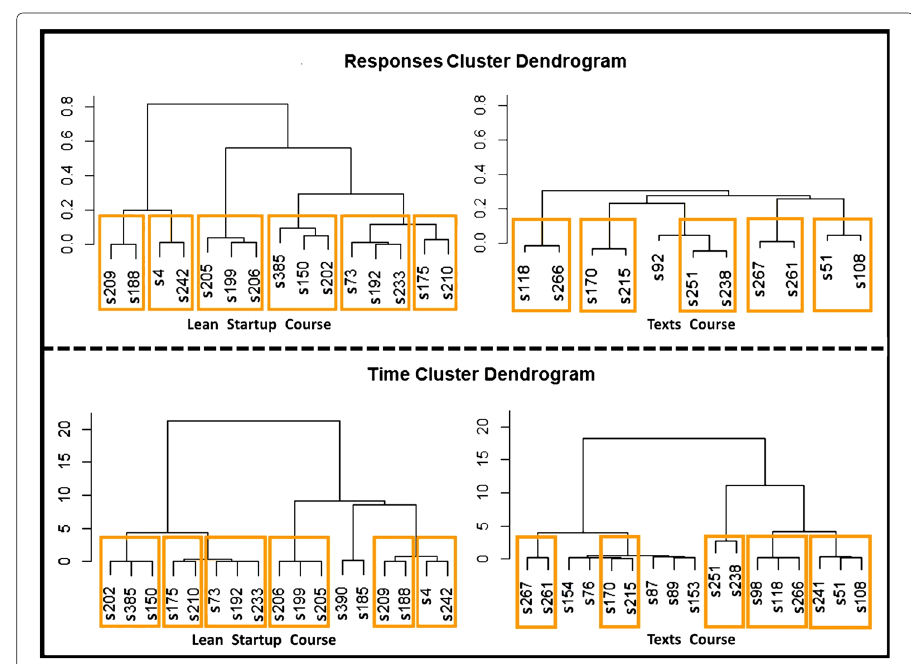
Fig. 2 Dendrograms for each one of the metrics